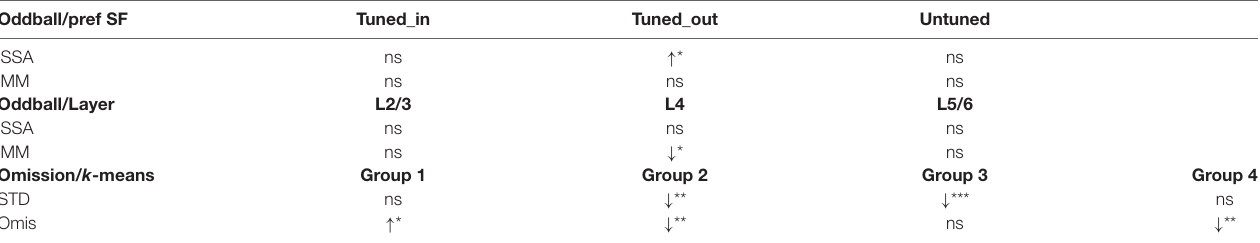
TABLE 1 | Summary of differences in oddball and omission responses between WT and FX animals. Oddball/pref SF Tuned_in Tuned_out